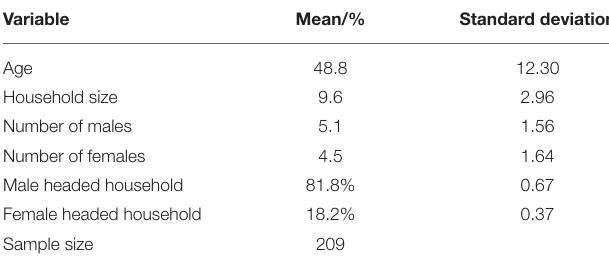
TABLE 2 | Demographic characteristics of the